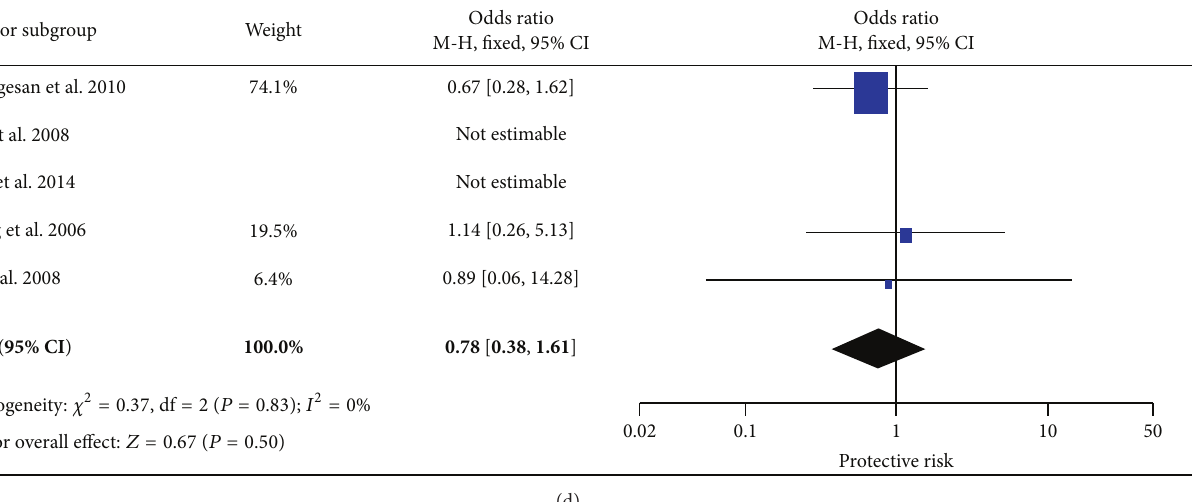
Figure 4: Forest plots of the association of LEPR p.K656N with T2DM. (a) Allele model, (b) dominant model, (c) homozygote model, and (d) recessive model.